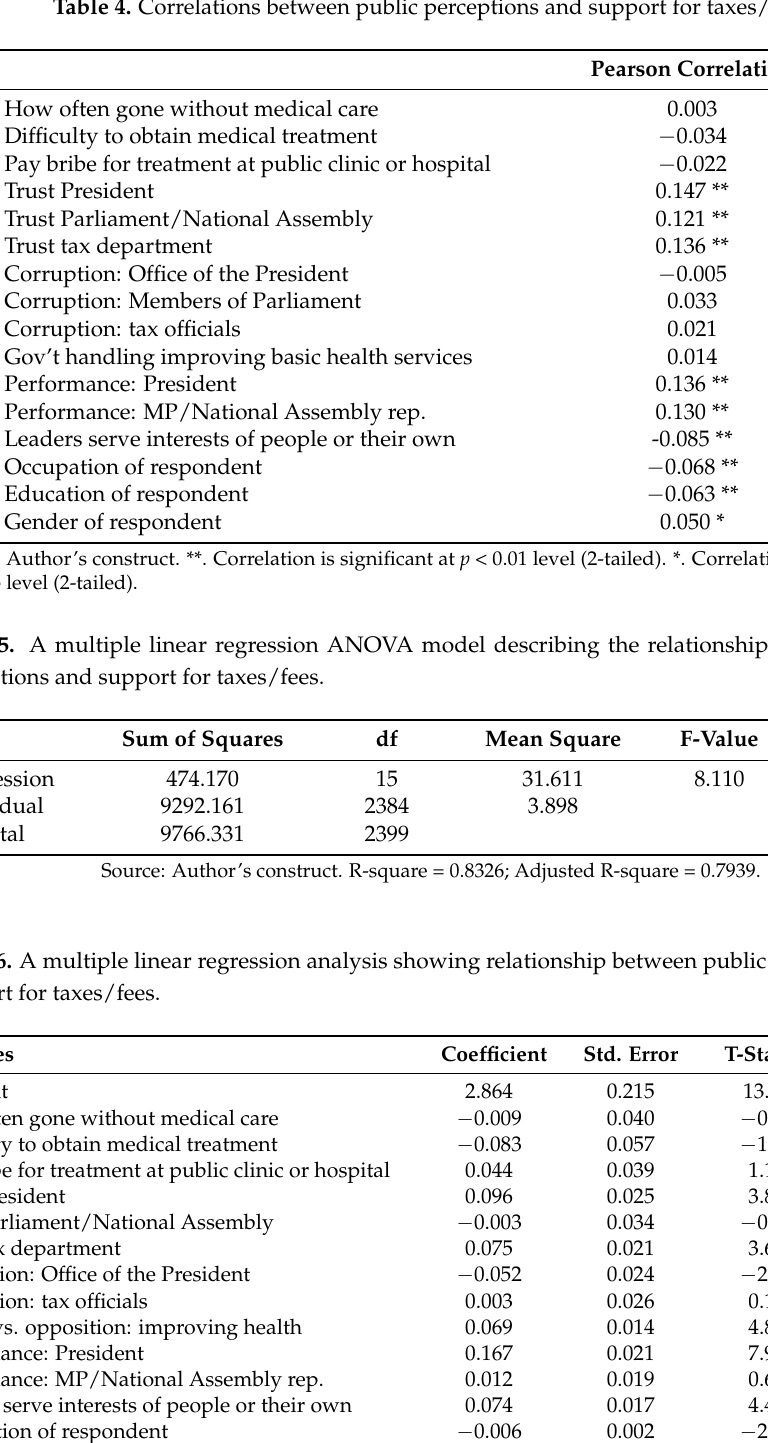
Table 4. Correlations between public perceptions and support for taxes/fees.